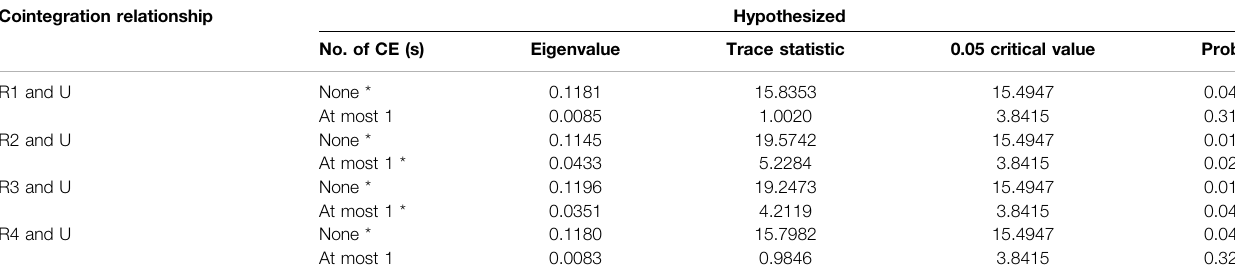
TABLE 4 | J-J cointegration test.